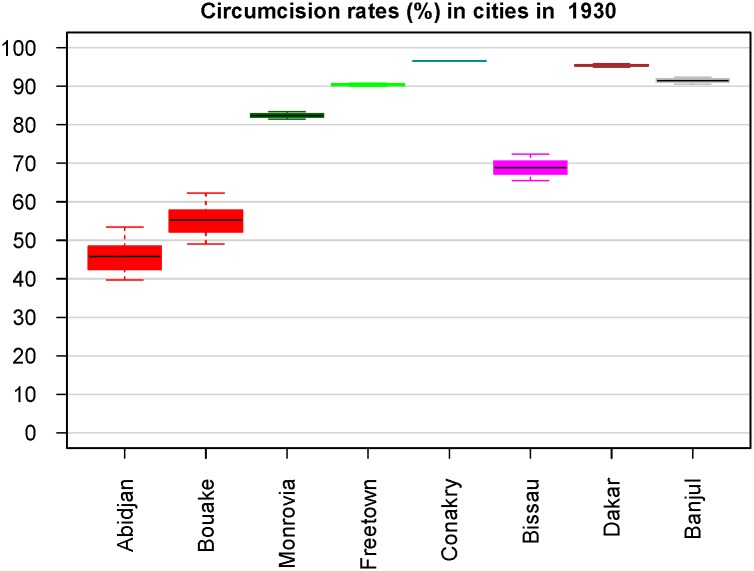
The estimated MC frequencies in 8 large cities at or near the sooty mangabey range in 1930.Cities of the same country appear with the same color. The country colors are the same as in Fig 2 (see Fig 2 legend).